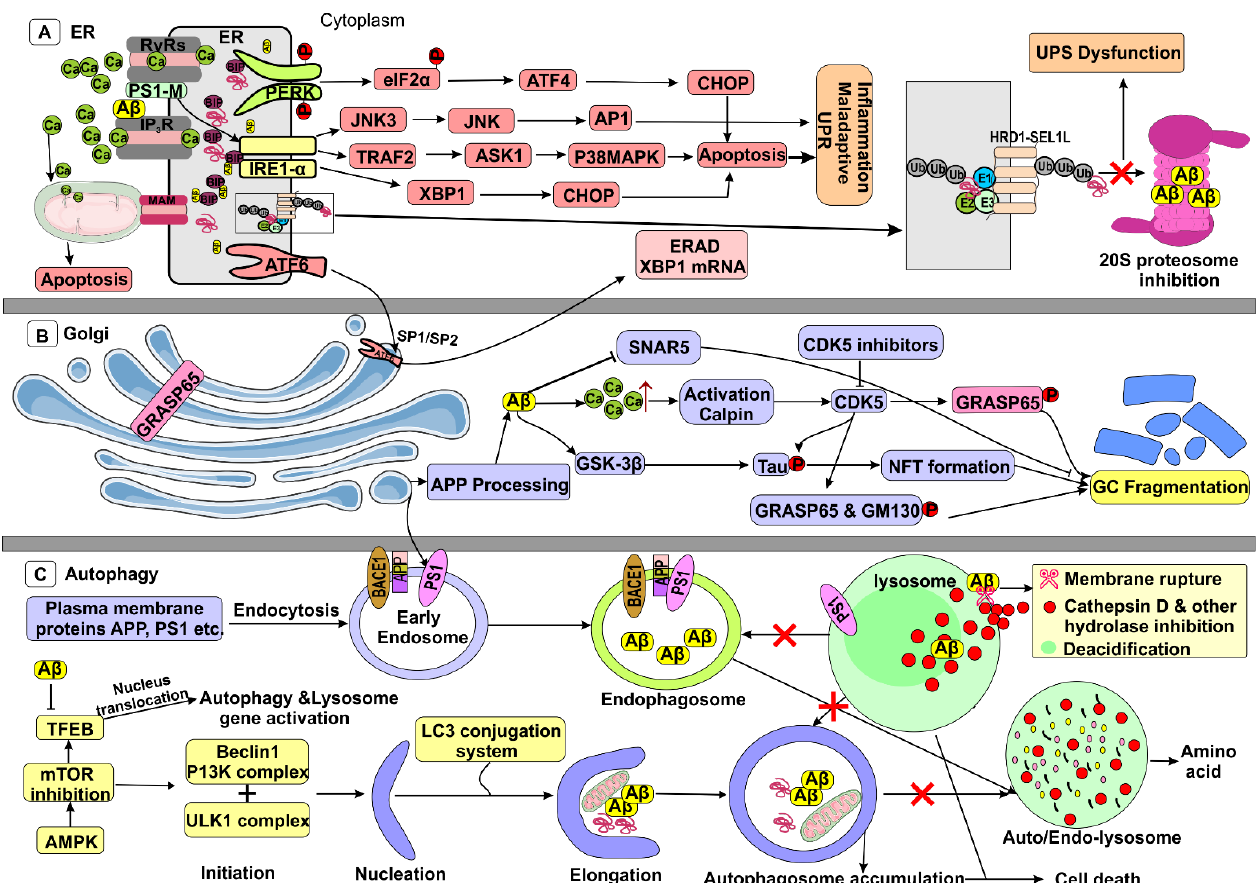
Figure 4. The molecular mechanisms of Aβ prompted ER, GC and Lysosome dysfunction: Aβ induces the ER stress via increasing Ca 2+ outflux from ER through IP 3 R and RyR which accelerates the apoptosis via mitochondrial Cyt C release. The maladaptive UPR signalling in ER is facilitated via PERR, IRE1 receptors where the cells undergo apoptosis and inflammation. Aβ interacts with 20S proteosome and inhibits its functions such as degradation of the unfolded proteins. ATF6 is transported and processed in GC which acts as a transcription factor, transcribes the genes related to ERAD and XBP1. GC fragmentation is induced by the activation of several kinases which phosphorylates the GRASP65 and GM130. Autophagy and lysosome gene transcription is impeded via TFEB inhibition. On the other hand, the autophagy elongation is perturbed, as well as inhibition of autophagosome/endophagosome fusion with lysosome enhances its accumulation which drives cell death. In addition, Aβ ruptures the lysosome membrane, deacidify the niche and inhibits its hydrolases. All together the stress recovery mechanism is completely affected by the Aβ.